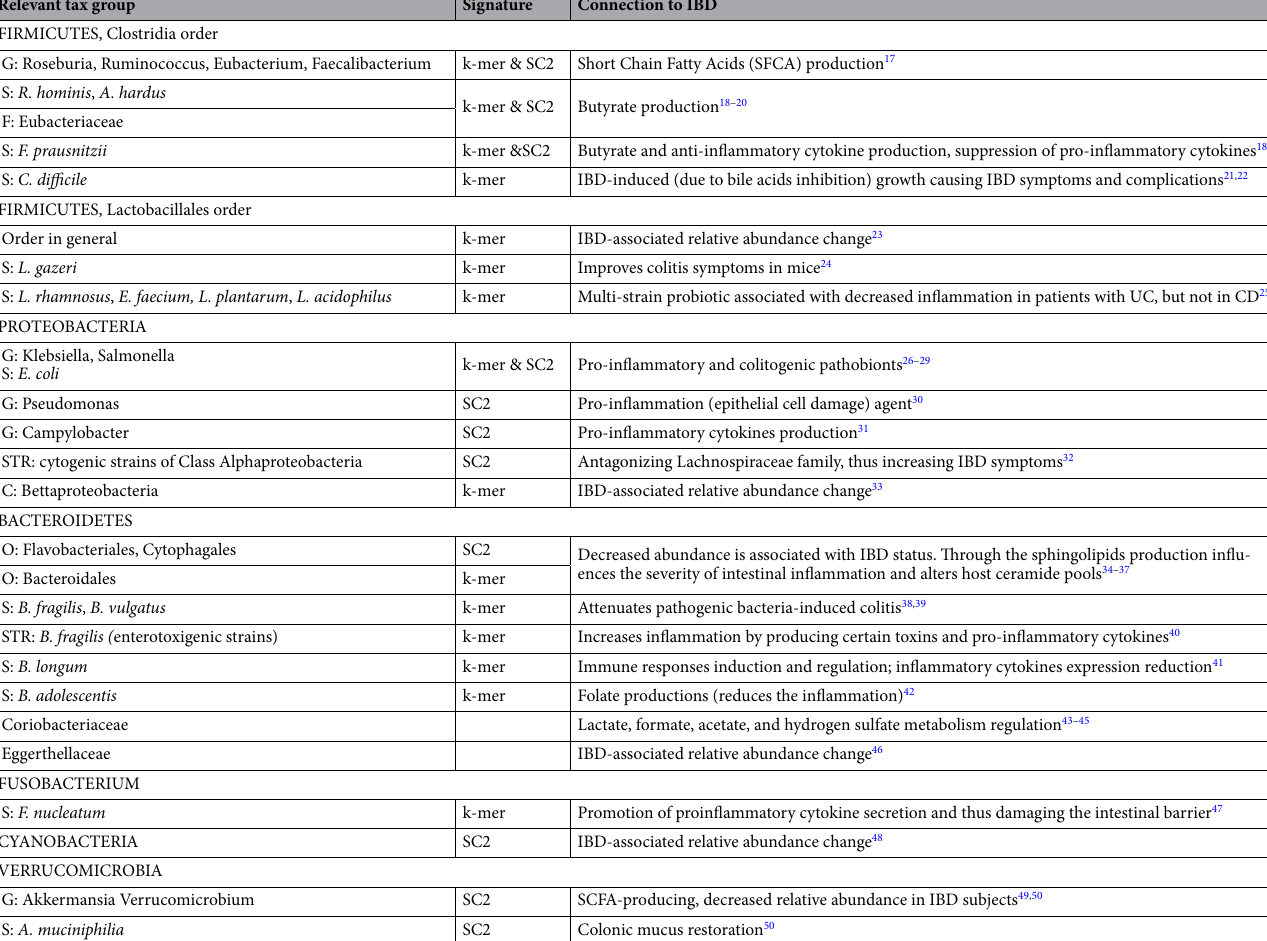
Table 3. Taxa detected in SC2 taxonomic consensus signature and k-mer-based signature connected to IBD through the literature review. Taxonomy levels are marked as: Class (C), Order (O), Family (F), Genus (G), Species (S), Strain